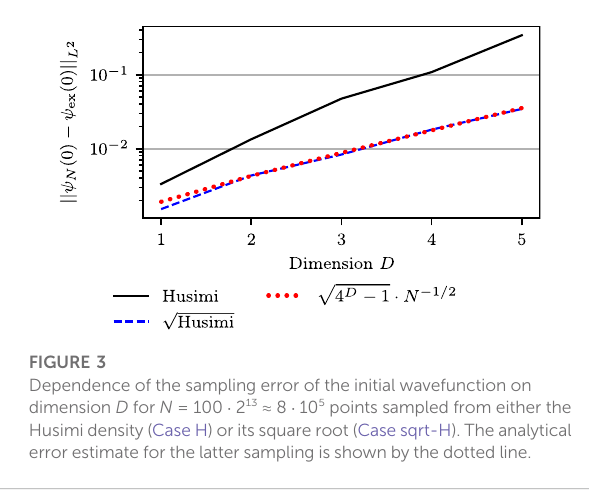
FIGURE 3 Dependence of the sampling error of the initial wavefunction on dimension D for N = 100 · 2 13 ≈ 8 · 10 5 points sampled from either the Husimi density (Case H) or its square root (Case sqrt-H). The analytical error estimate for the latter sampling is shown by the dotted line.